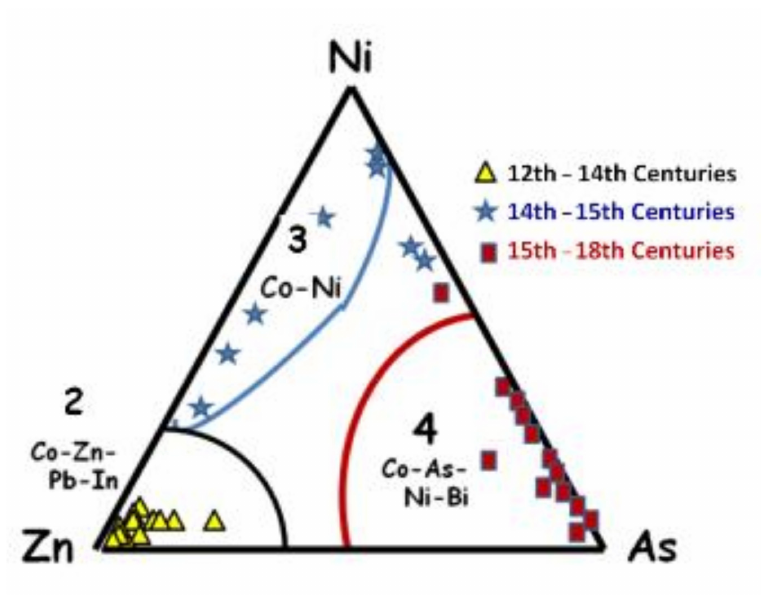
Figure 4. Ternary diagrams of the compositional Ni, Zn and As ratios showing the Groups 2, 3 and 4 identified by Gratuze et al. [90]; glaze data are indicated with triangle, star, and square labels;